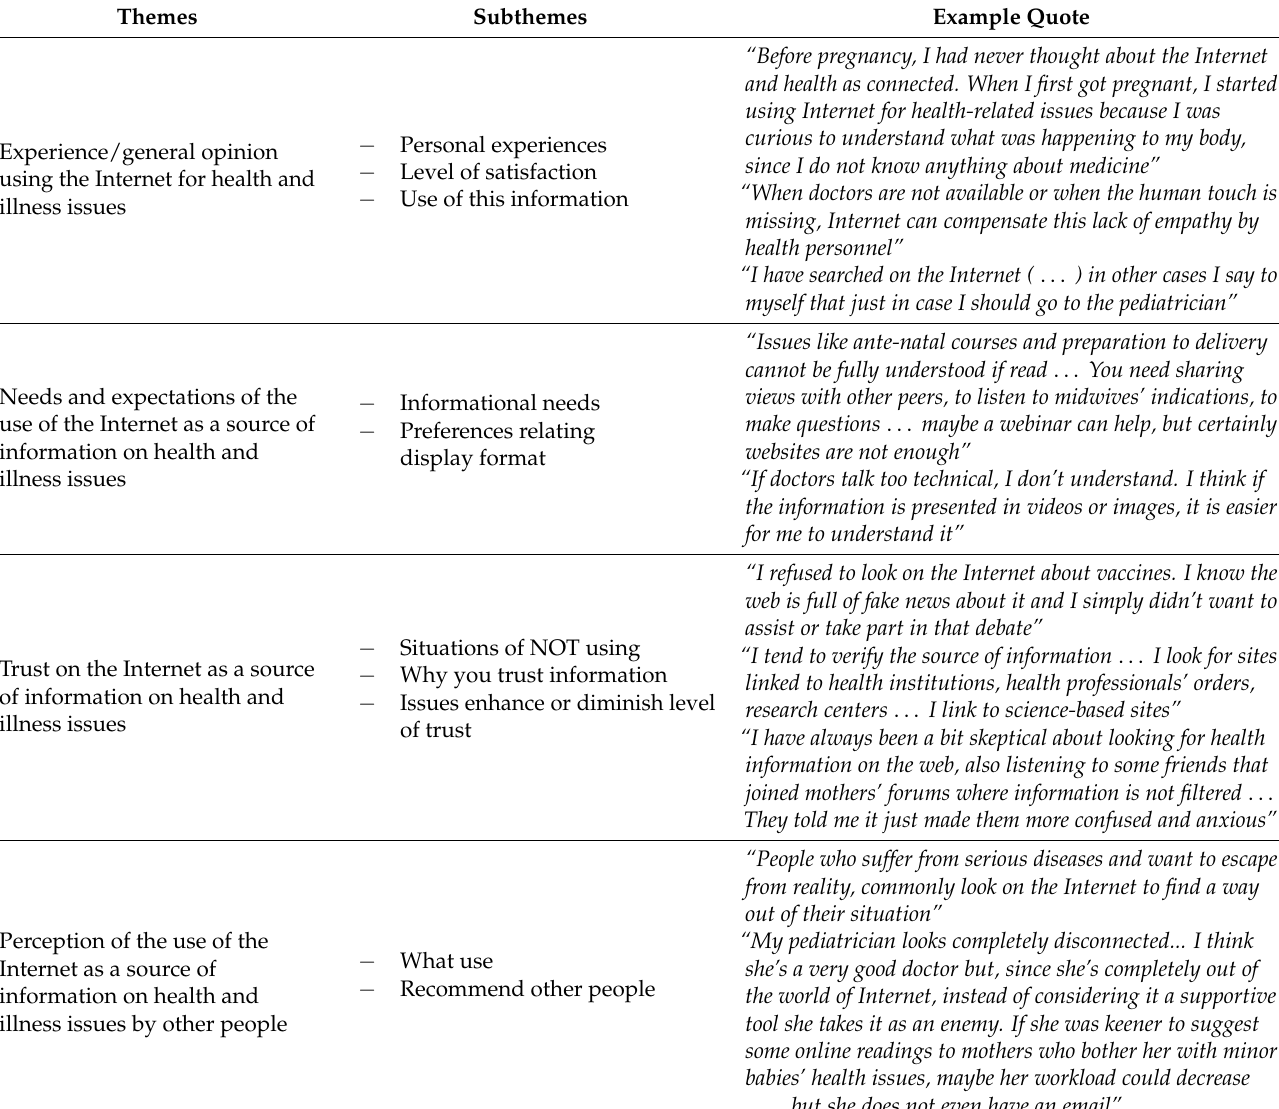
Table 2. Themes and subthemes identified in the thematic